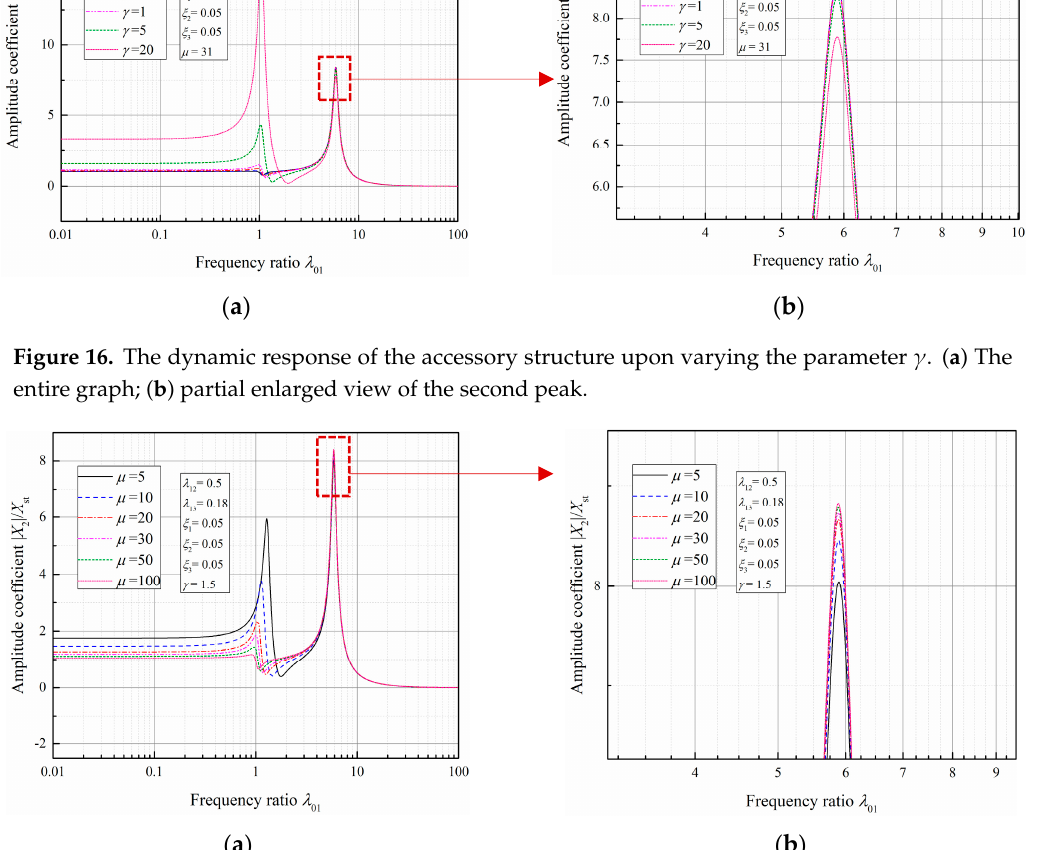
Figure 17. The dynamic response of the accessory structure upon varying the parameter µ . ( a ) The entire graph; ( b ) partial enlarged view of the second peak.